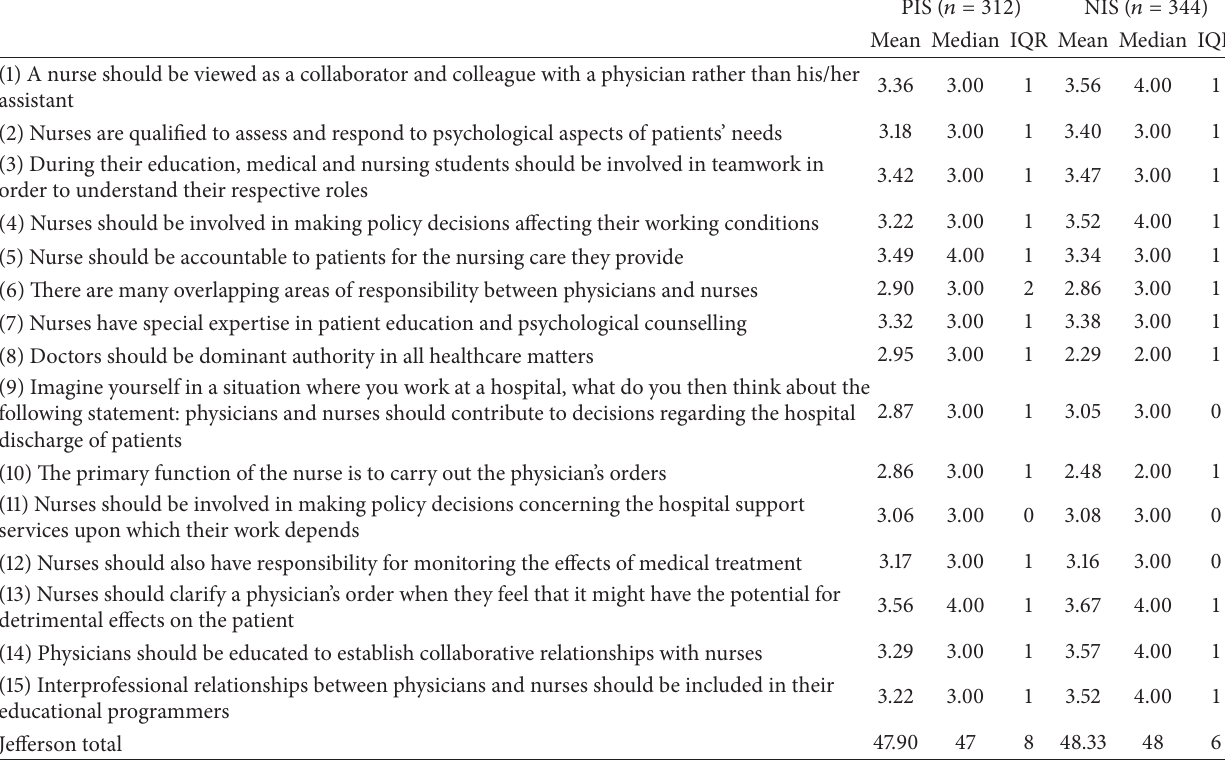
Table 3: Mean and median for the attitudes towards collaboration, within PIS and NIS, as measured by the Jefferson Scale items and total score.